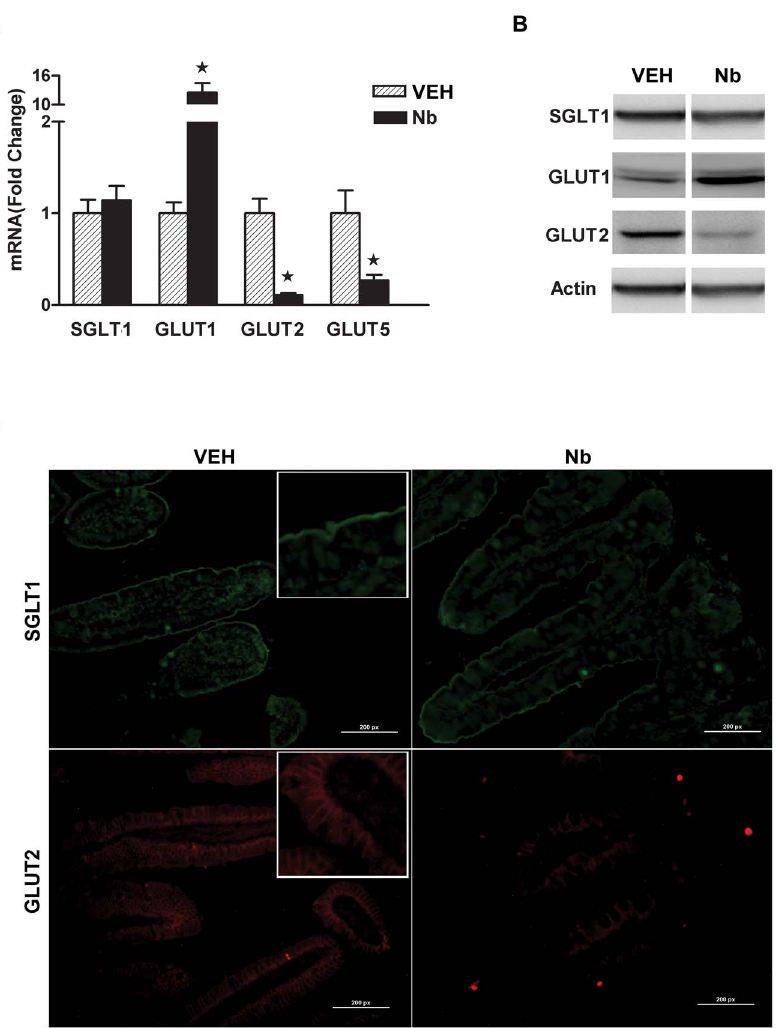
Figure 2. Nippostrongylus.brasiliensis infection alters the expression of glucose transporters. WT mice were treated with vehicle (VEH) or were infected with N. brasiliensis (Nb). At day nine post inoculation, full thickness sections of small intestine were prepared for (A) real-time qPCR to measure the mRNA expression of glucose transporters (B) Western blot analyses for glucose transporters, using actin as a loading control and (C) immunofluorescence staining for glucose transporters on the surface of villi of small intestine. The photomicrographs are representative of five different replicate slides. Values shown are means 6 SE; p , 0.05 vs VEH Control.